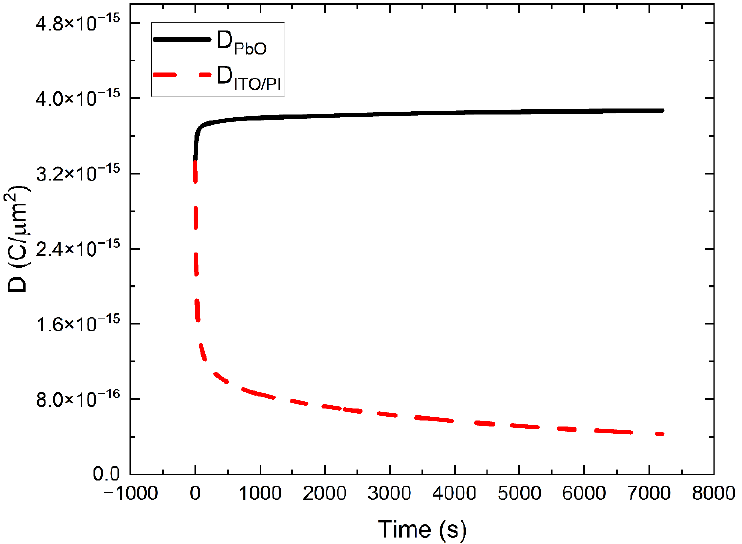
Figure 8. Electric displacement field (D(t)) at the ITO/PI interface (dashed red) and throughout the bulk of a-PbO (solid black) as functions of time for an applied field of 20 V/µm.